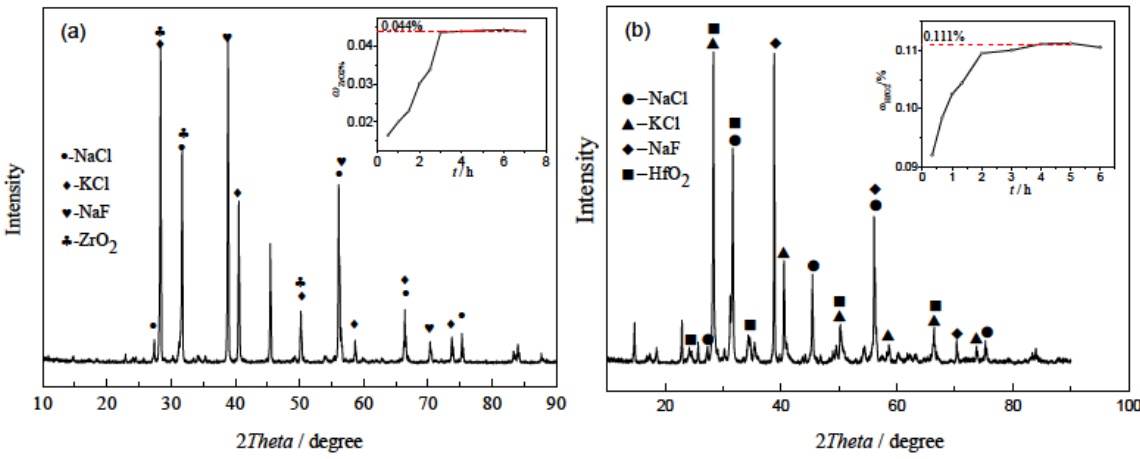
Figure 1: Dissolved quantity of ZrO 2 HfO 2 changes over time at 700 ∘ C (a) ZrO 2 (b) HfO 2